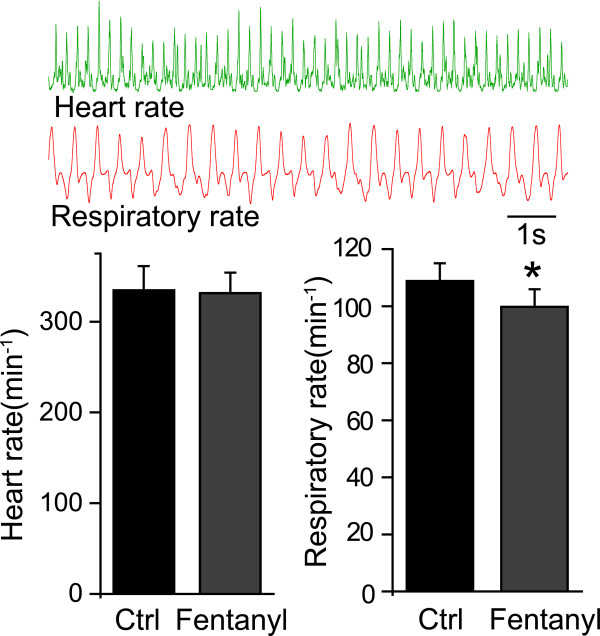
The effect of fentanyl on heart rate and respiratory rate. The two upper panels show examples of heart rate and respiratory rate recordings. The left, lower graph shows that fentanyl did not alter heart rate. The right, lower graph shows that fentanyl had a small but significant effect on respiratory rate. *P < 0.05.